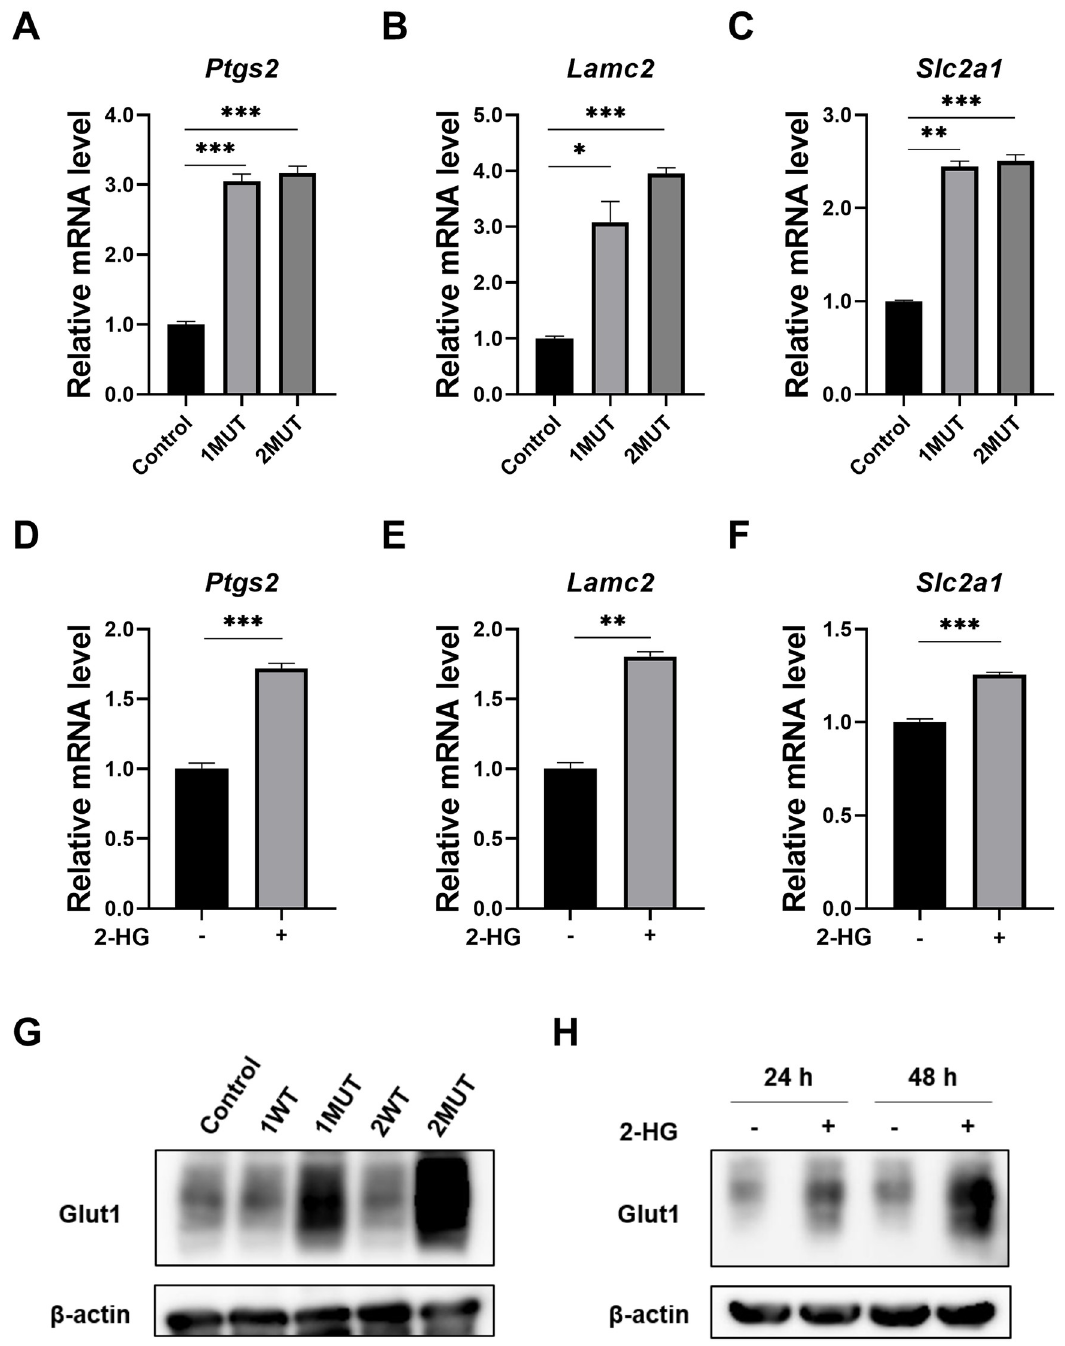
Fig 3. Enhanced expression of Glut1 by the expression of IDH1/2 mutants and 2-HG. (A–C) Induction of Ptgs2 (A), Lamc2 (B), and Slc2a1 (C) in MEF cells stably expressing the IDH1 or IDH2 mutant. Expression was determined by real time-PCR. Expression of Gapdh was used as an internal control. The data represent mean ± SD of three independent experiments. � p < 0.05, �� p < 0.01, ��� p < 0.001. (D–F) Induction of Ptgs2 (D), Lamc2 (E), and Slc2a1 (F) in MEF cells treated with 300 μ M of 2-HG for 24 h. �� p < 0.01, ��� p < 0.001. (G) Elevated expression of Glut1 protein by the IDH1/2 mutants. Expression of β -actin served as an internal control. The data are representative of three independent experiments. (H) Elevated expression of Glut1 protein in response to the treatment with 300 μ M of 2-HG. Cell lysates were harvested at 24 h or 48 h after treatment and subjected to Western blotting.